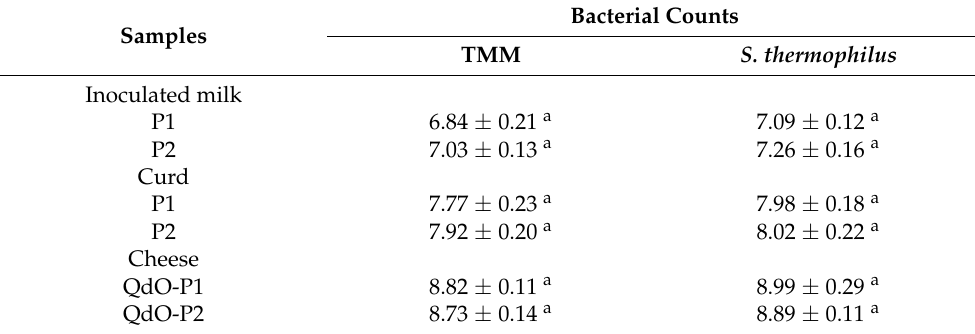
Units are log CFU/mL for liquid samples and log CFU/g for solid samples. Results indicate mean values ± S.D. of nine plate counts (carried out in triplicate for three independent productions). Data within a column followed by the same letter are not significantly different according to Duncan